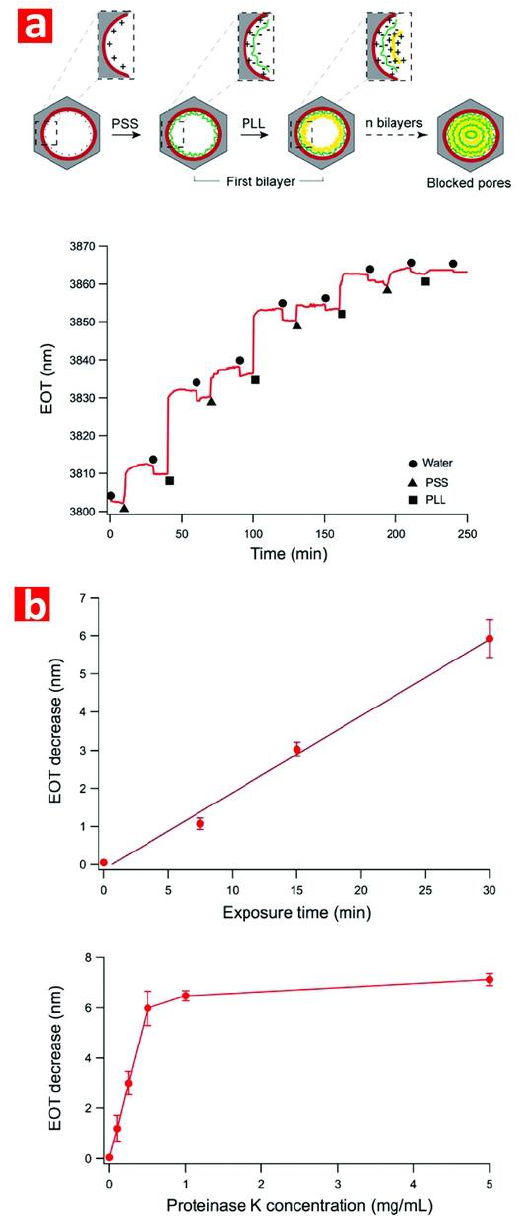
Figure 13. Examples of applicability of NAA-PCs in chemo- and biosensing applications. ( a ) Real-time monitoring of chemical functionalization of NAA-FPIs by polyelectrolyte layers using RIfS. ( b ) Sensing performance of enzymatic sensor as a function of exposure time and concentration upon digestion of polyelectrolyte layers. Reproduced from [142], with copyright permission from American Chemical Society,